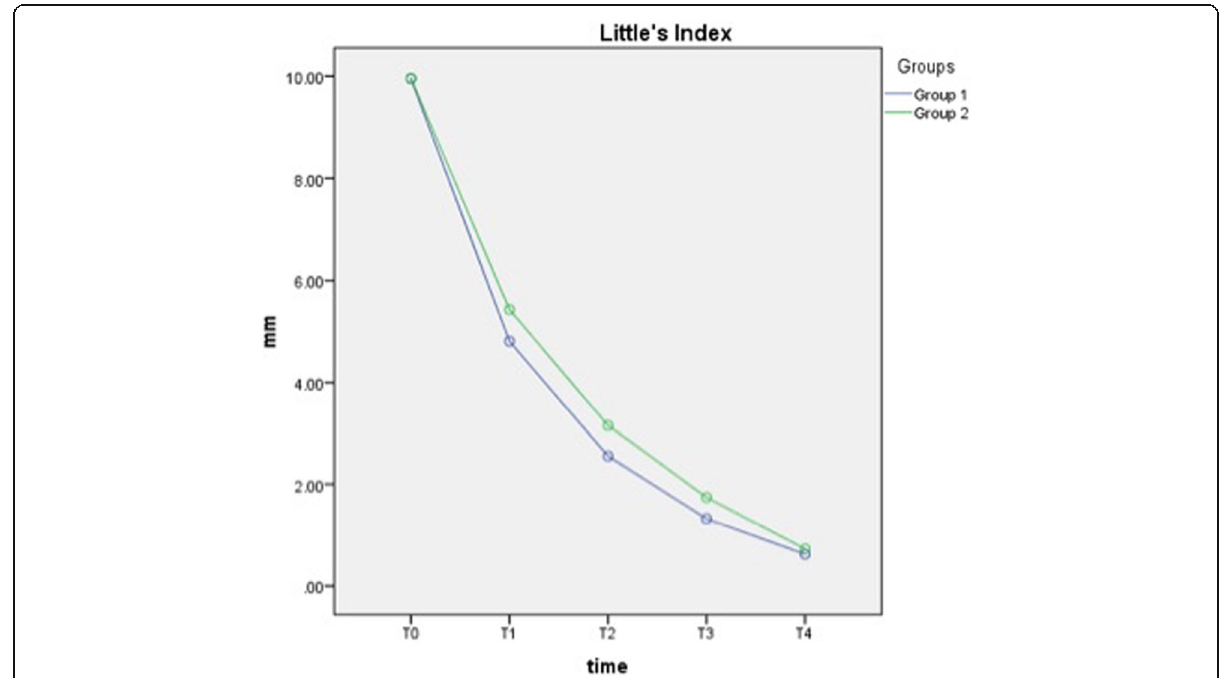
Fig. 3 Change of the mean irregularity scores over time